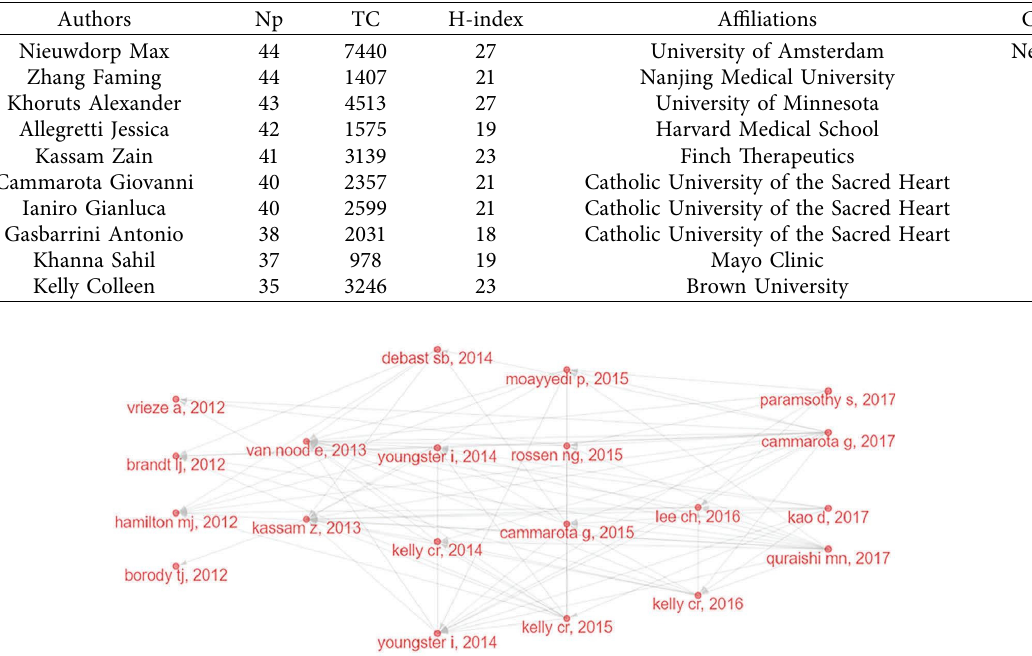
Figure 5: Historical FMT-related citation network (each dot displays a paper, the lines between dots highlight the links between studies, and the corresponding papers are shown in Table